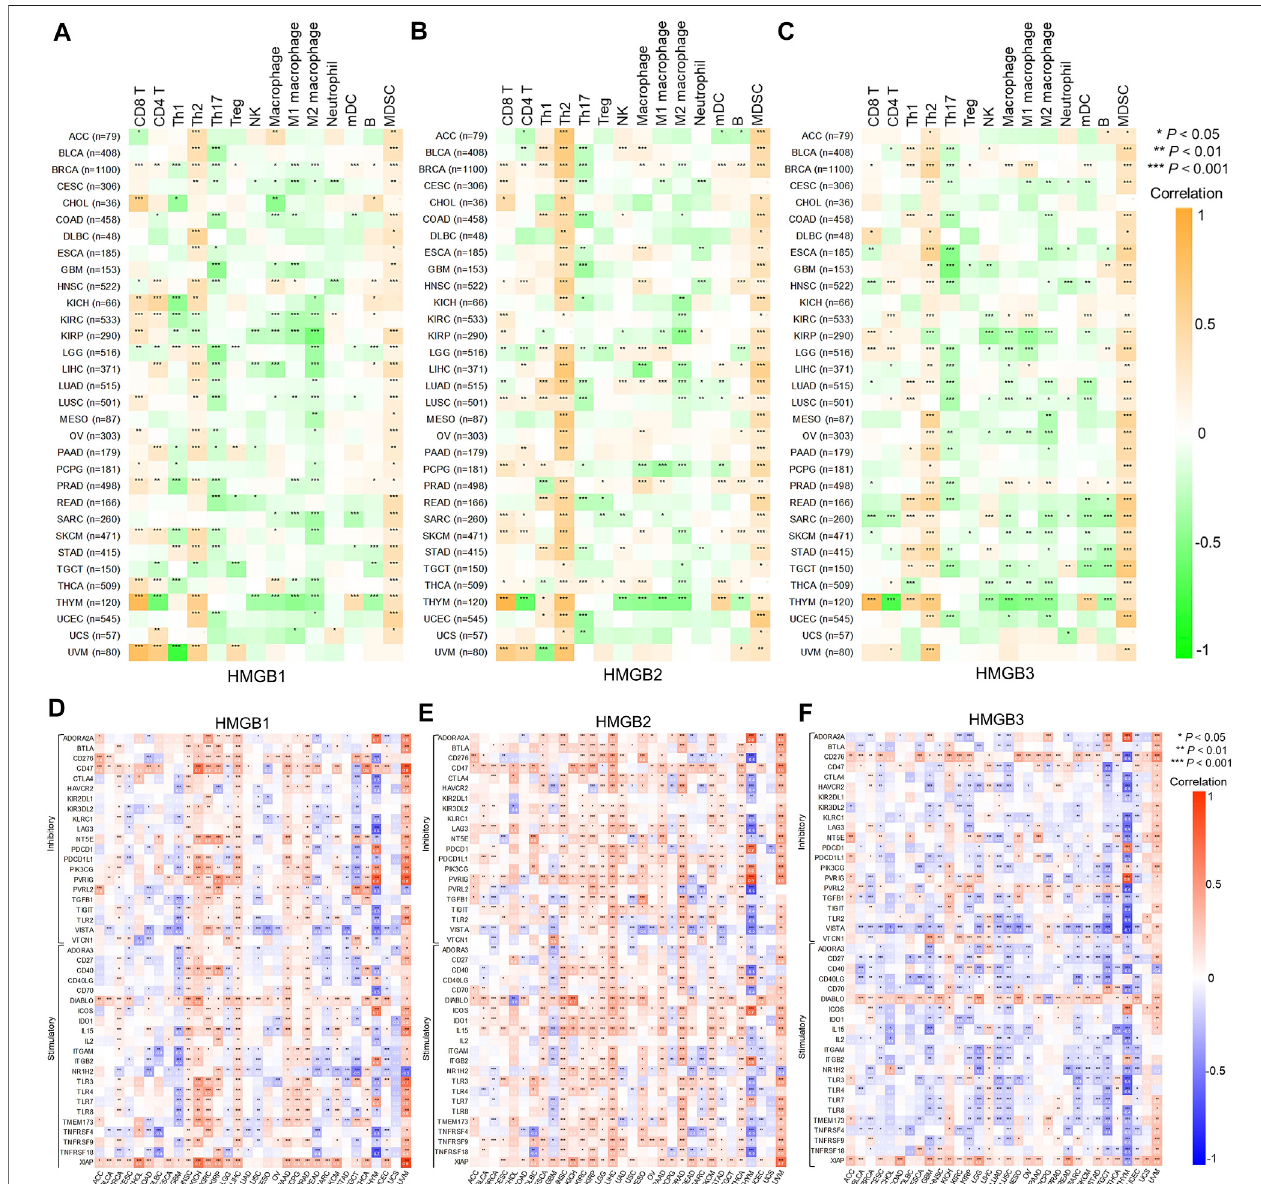
FIGURE 5 | Correlations between High Mobility Group Box (HMGBs) expression and (A – C) immune in fi ltration and (D – F) ICP genes expression in cancers. Th, helper T cell; Treg, regulatory T cell; NK cell, natural killer cell; mDC, myeloid dendritic cell; MDSC, myeloid-derived suppressor cell.